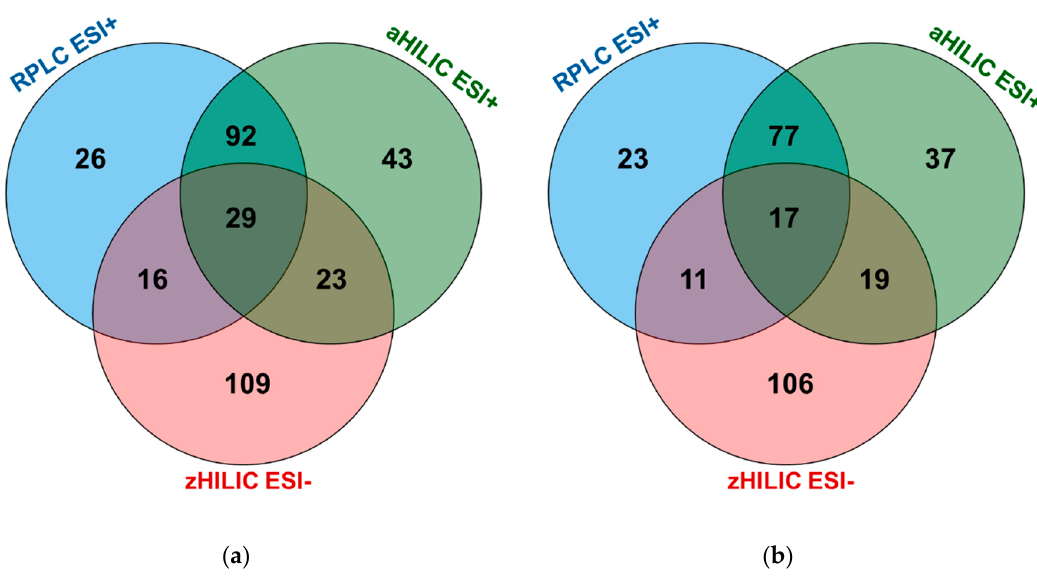
Figure 5. Overall metabolite annotations for RPLC ESI+, aHILIC ESI+, zHILIC ESI- with ( a ) all IM-AIF and AIF acquisition modes; and ( b ) IM-AIF and AIF ramped 10–60 and 30–60 eV acquisition modes.